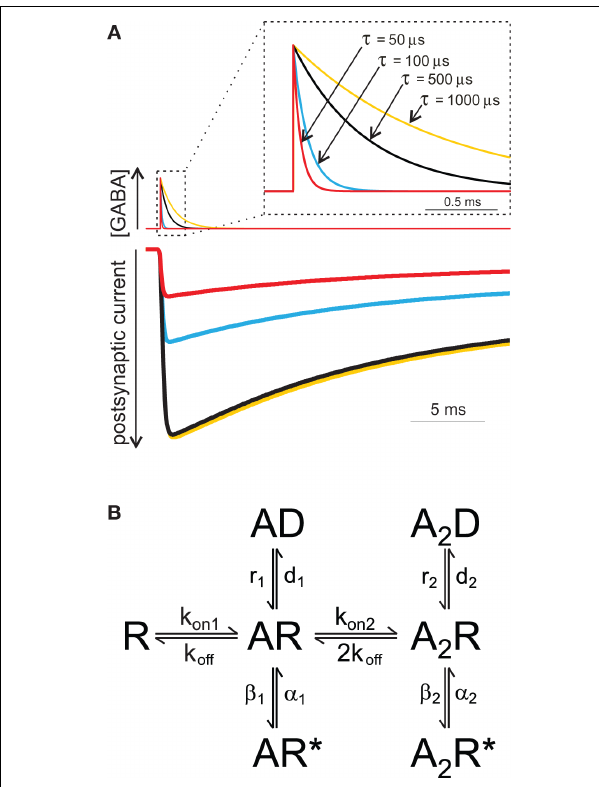
FIGURE 1 |The amplitude of simulated IPSCs depends on the neurotransmitter time exposure. (A) Currents simulated using the Jones andWestbrook model (rate constants from Mozrzymas et al., 1999) elicited by four different GABA pulses. At GABA pulses with τ lower than ∼ 500 μ s, the current amplitude strongly depends on GABA pulse length. Please note that current evoked by fast clearance GABA pulses ( τ = 50 μ s) is markedly smaller that that obtained by longer GABA exposures. (B) Jones and Westbrook’s (1995) model. It assumes the sequential binding of two GABA molecules and includes open (AR*, A 2 R*) and desensitized (AD, A 2 D) states originating from both mono- and doubly liganded closed states (AR, A 2 R).This gating scheme has been extensively used in the investigation of the gating properties of GABA A R and, although oversimplified, this model reproduces the basic features of GABA A R (Jones andWestbrook, 1995; Mozrzymas et al.,